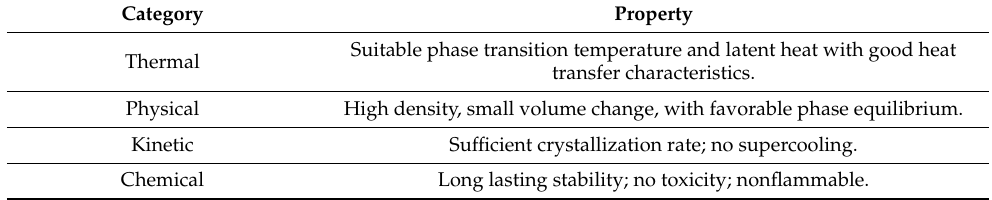
Table 1. Selection criteria of PCM.